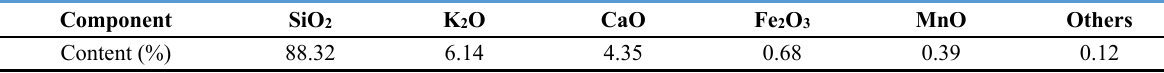
Table 2. Chemical characterization of silica fume.